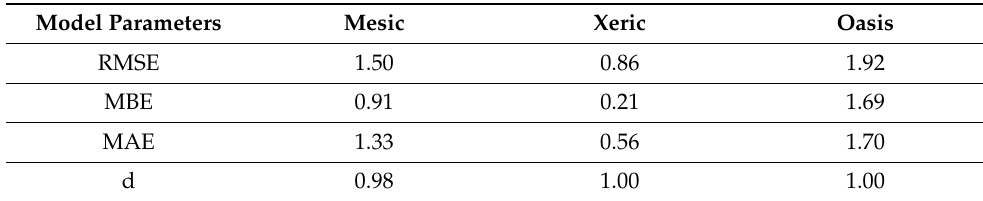
Table 2. Model evaluation using basic statistics between observed and simulated air temperatures at 2 m. Model